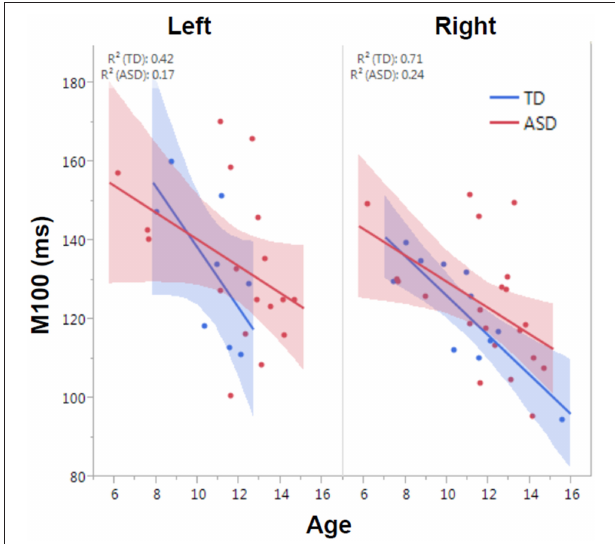
FIGURE 3 | Developmental trajectory of left and right auditory M100 latency. M100 latency shortened with age across the population ( p < 0.0001 ). Although no group difference in rate of maturation was observed, the TD group trended toward faster maturation.